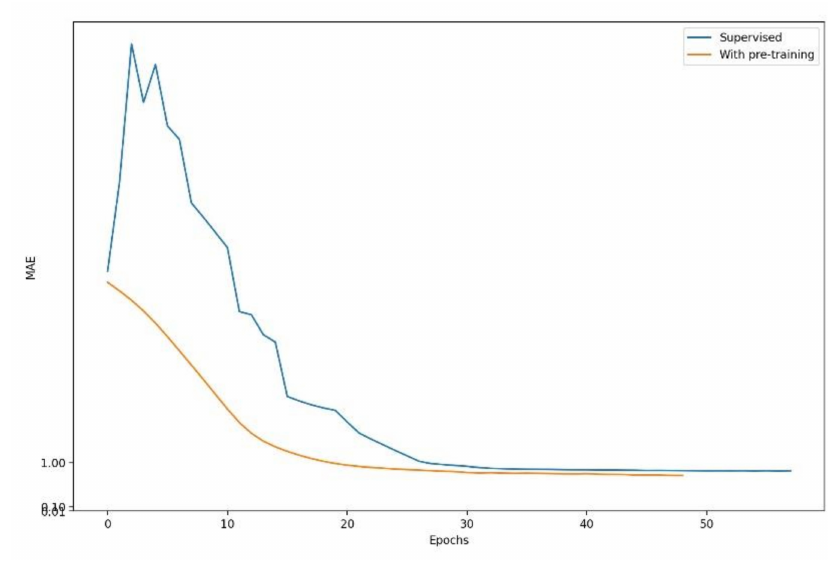
Figure 10. The model with self-supervised